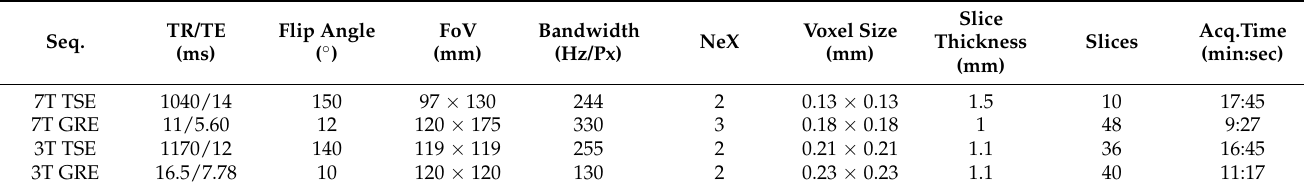
Table 1. List of main parameters used for MRI